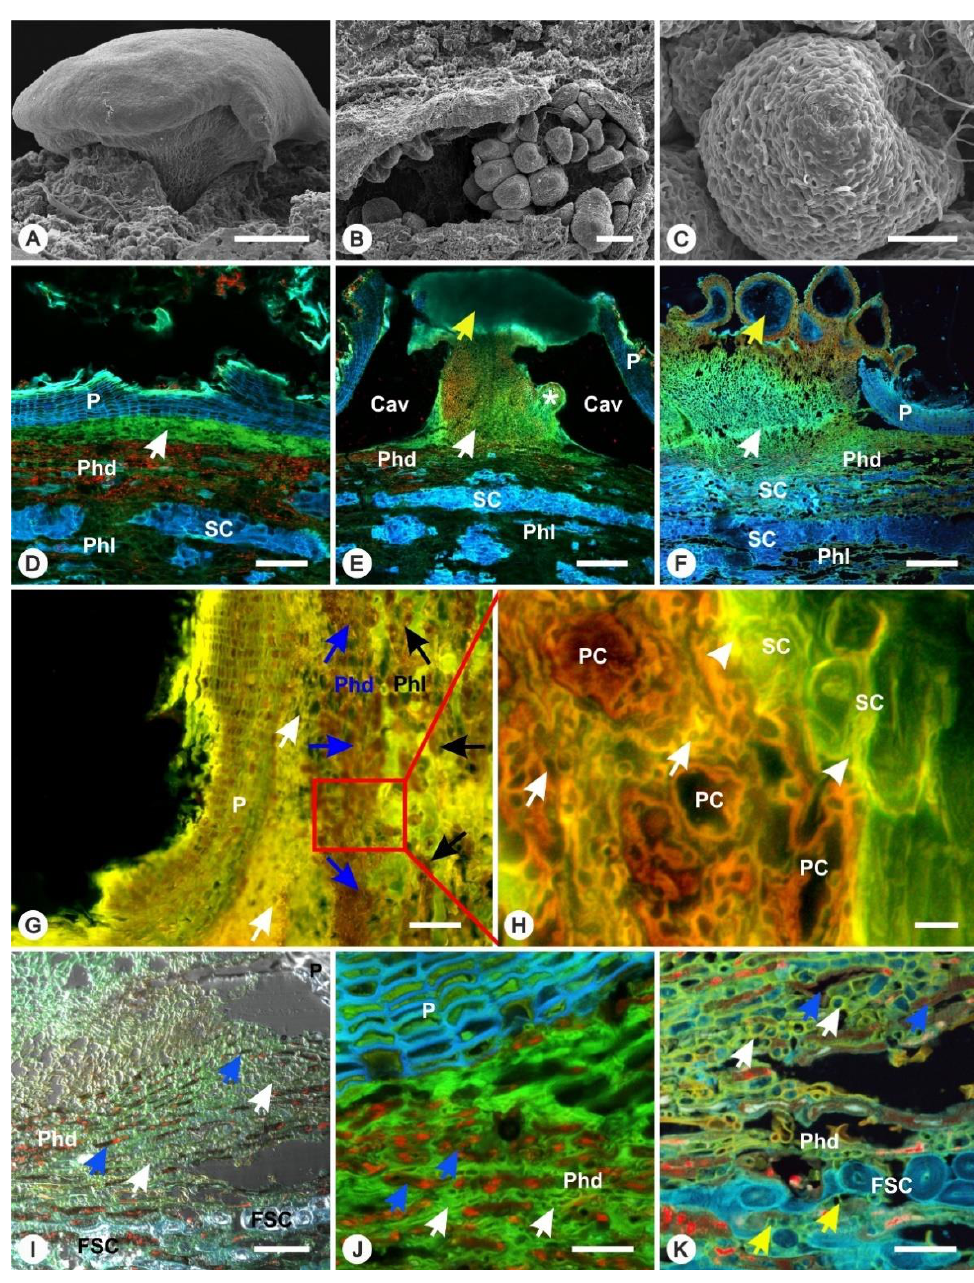
Figure 3. Histopathological assessments of the periderm layer disintegration using scanning electron ( A – C ), confocal laser scanning ( D – F , I – K ) and fluorescence ( G , H ) microscopies. ( A ) Fruiting bodies in the anamorph developmental stage. ( B ) Fruiting bodies in the teleomorph developmental stage. ( C ) A detailed view of the perithecium surface. ( D ) The early stage of the stroma (white arrows) that was formed between phelloderm and phellem layers. Cross-section. ( E ) Maturation of the anamorph fruiting bodies (conidioma) (yellow arrow) and the formation of new juvenile fruiting bodies (asterisk) on the stroma (white arrow). Cross-section. ( F ) Mature teleomorph perithecia (yellow arrow) outgrowing from the stroma (white arrow) in the crack of the phellem layer. Cross-section. ( G ) Juvenile stroma hyphae (white arrows), localized in between phellem and phelloderm layers, induced a deposition of brown colored polyphenolic compounds inside the living parenchyma cells of phelloderm (blue arrows) and phloem (black arrows). Radial section. ( H ) Closeup view of the previous image showing the intercellular hyphae (white arrows) that separated parenchyma cells and sclereid clusters in the phelloderm. White arrowheads point to the sites of the sclereid cluster cell wall disintegration that was caused by the intercellular hyphae. Radial section. ( I – K ) Phelloderm disintegration by mature stromata hyphae (white arrows) in anamorph ( J ) and teleomorph ( I , K ) developmental stages. The expanding hyphae (white arrows)